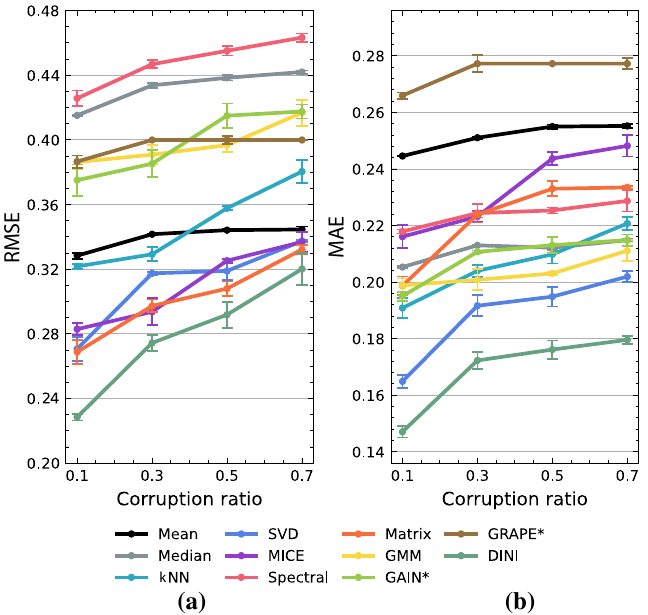
Figure 5. Error vs. corruption ratio for various imputation methods: ( a ) RMSE and ( b ) MAE. MCAR corruption on the Breast dataset was used for comparison.